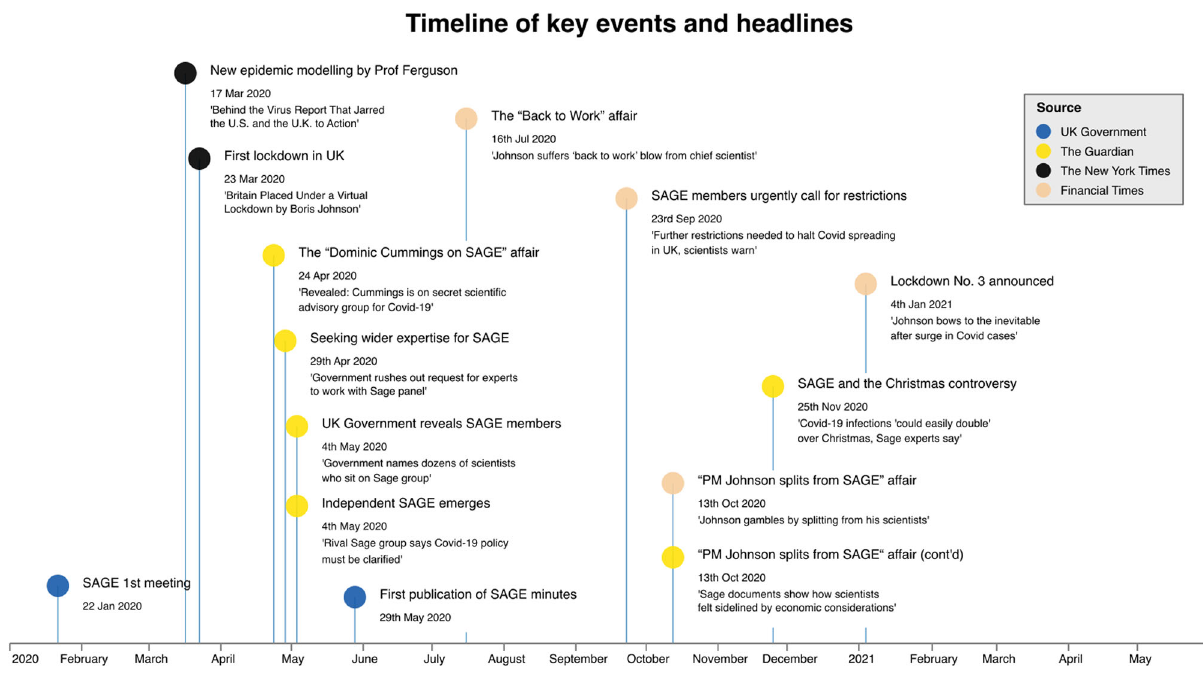
Fig. 1 Timeline of key events and headlines identi fi ed, based on a media review of The Guardian, The New York Times, and the Financial Times between January 2020 and May 2021. Titles of articles as quotes, and dates denote the publication of the article. See Supplementary Information 2 for reference data and the corpus of reviewed media